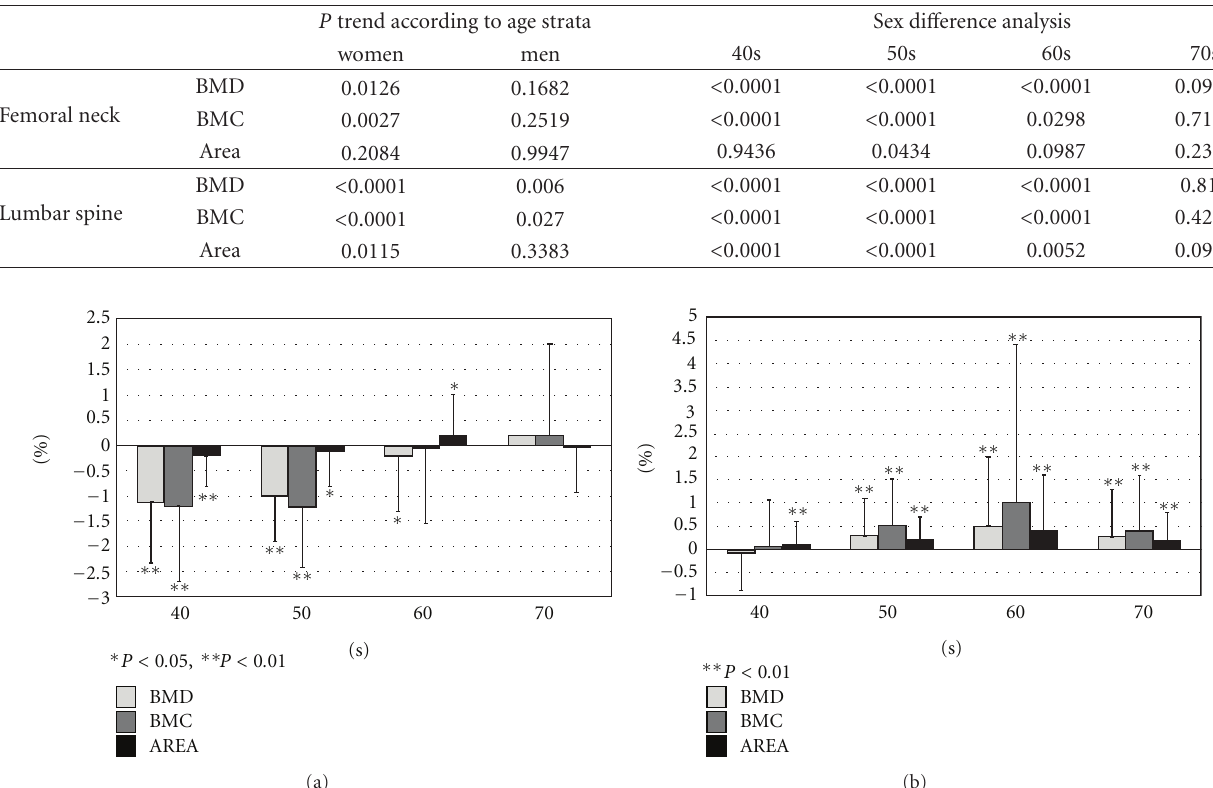
Figure 3: (a) Changes in the lumbar spine region by age group in women. Results are the mean ( ± SD) CR of four di ff erent age strata. ∗ P < 0 . 05, ∗∗ P < 0 . 01. (b) Changes in the lumbar spine region by age group in men. Results are the mean ( ± SD) CR of four di ff erent age strata. ∗∗ P < 0 .